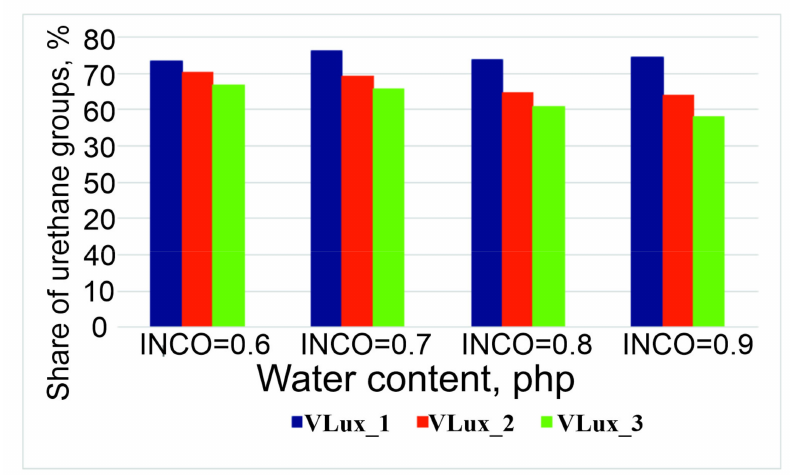
Figure 5. Change in the share of urea groups in the tested foams.